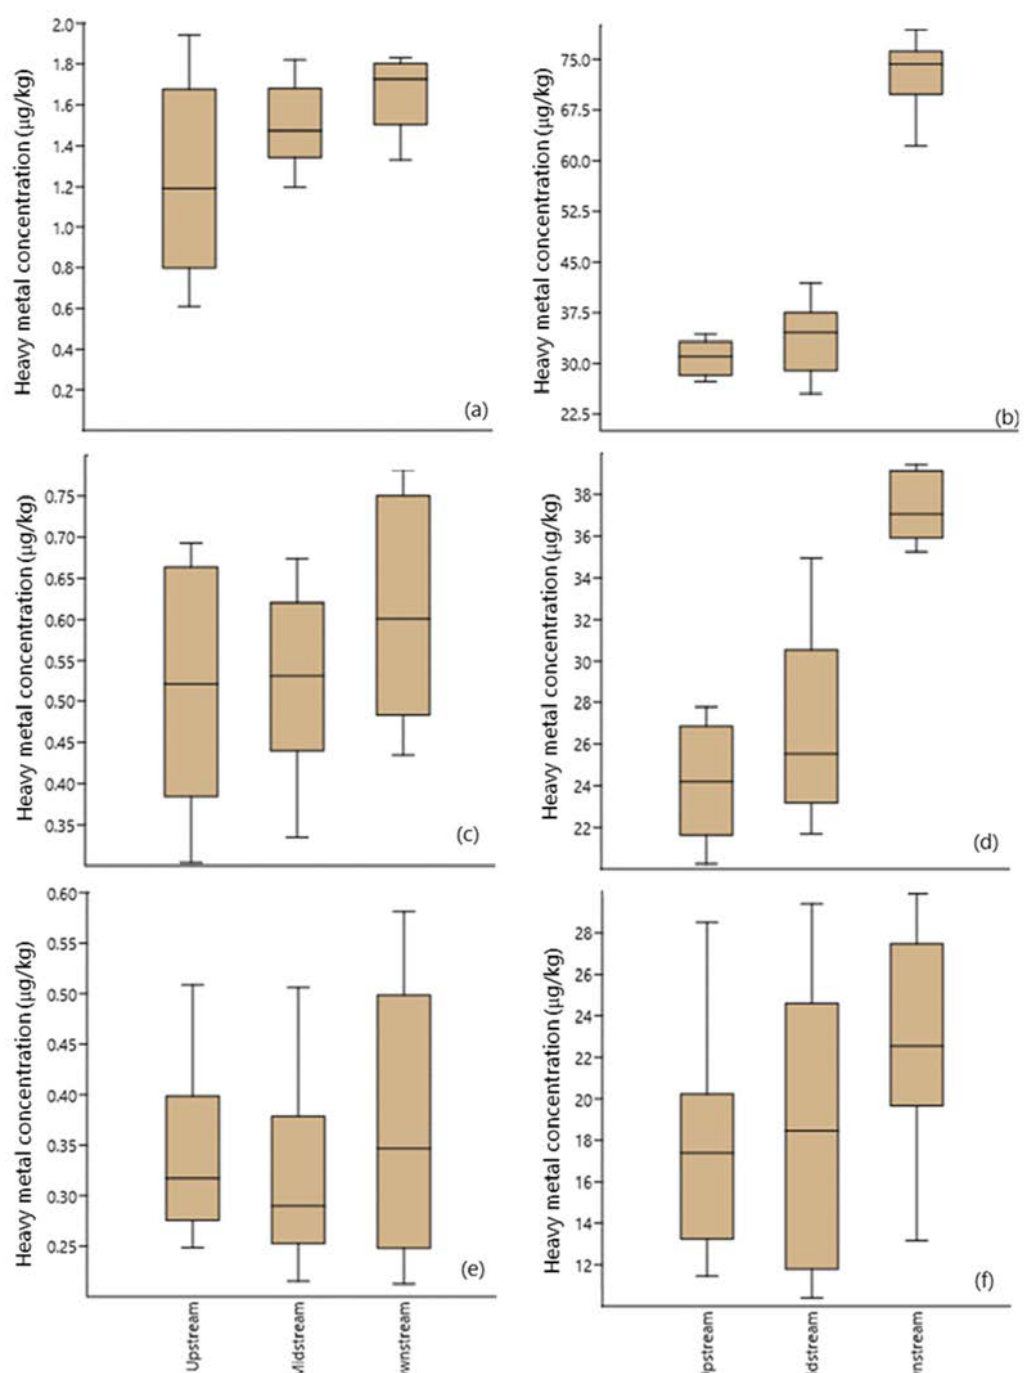
Fig. 4: Spatial distribution of Cd in gill (a), digestive tract (c) and flesh (e) and Pb in gill (b), digestive tract (d) and flesh (f) from Ciliwung River.